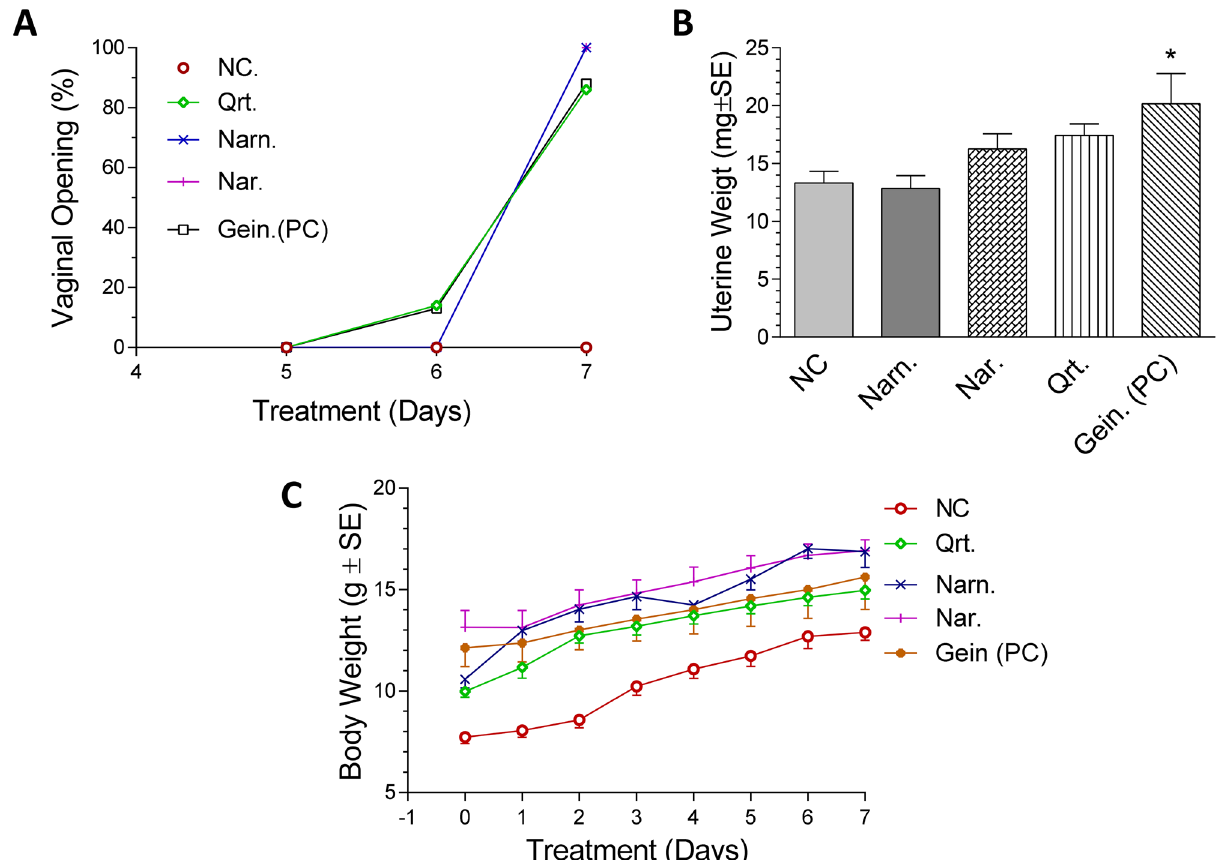
Figure 3. Estrogenic activity of quercetin, naringenin and naringin. ( A ) Vaginal opening (%) for the in vivo estrogenic activity groups of immature female mice. ( B ) Bar chart of average uterine weights (mg ± S.E.) of the in vivo estrogenic activity groups of female immature mice. ( C ) Body weight changes (g ± S.E.) of the in vivo estrogenic activity groups of immature female mice. NC negative control group receiving olive oil s.c., Qrt quercetin, Narn naringenin, Nar naringin, Gein (PC) genistein positive control phytoestrogen group. *Significant at p < 0.05 compared to negative control (NC) using One Way ANOVA followed by